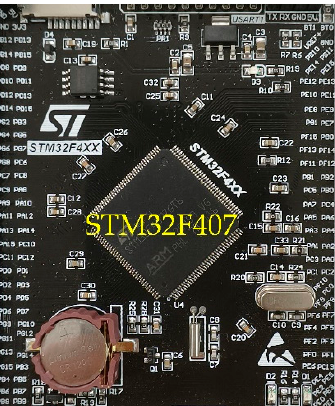
Figure 3. The STM32F407 used in the experiment.